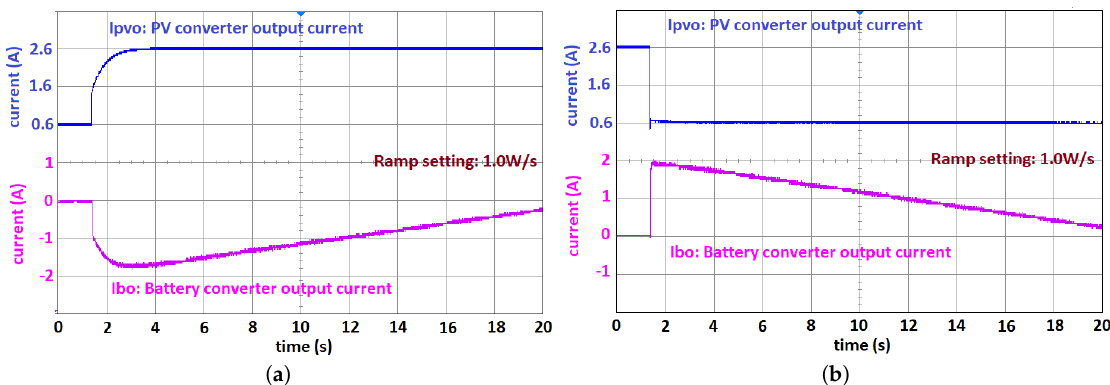
Figure 22. Experimental results: ( a ) ramp up response, and ( b ) ramp down response.